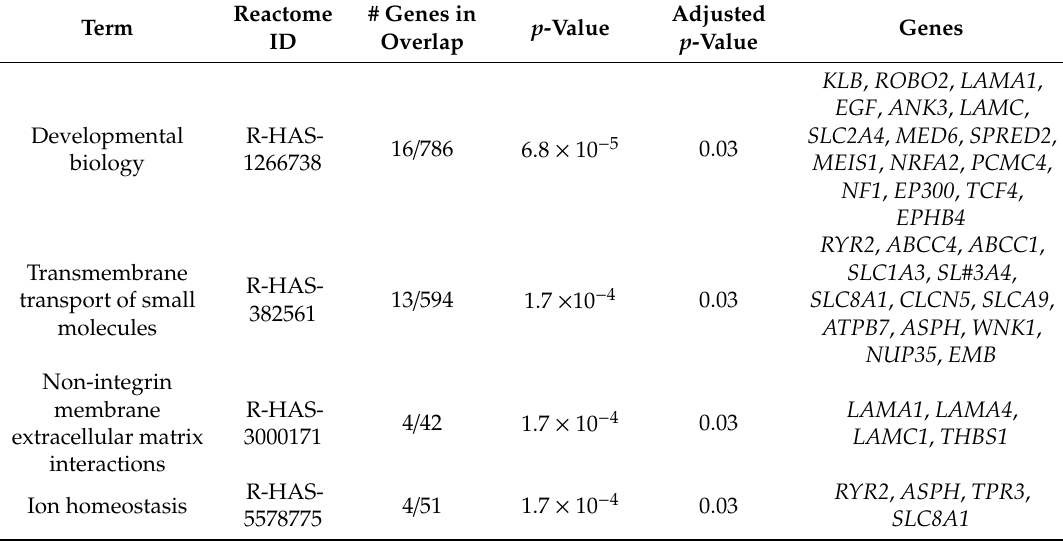
Table 2. Biological pathway analysis of SOX17 target genes harboring PAH-CHD patient rare deleterious variants. Data obtained using Reactome 2016. Pathways with false discovery rate (FDR)-adjusted p -value ≤ 0.05 are